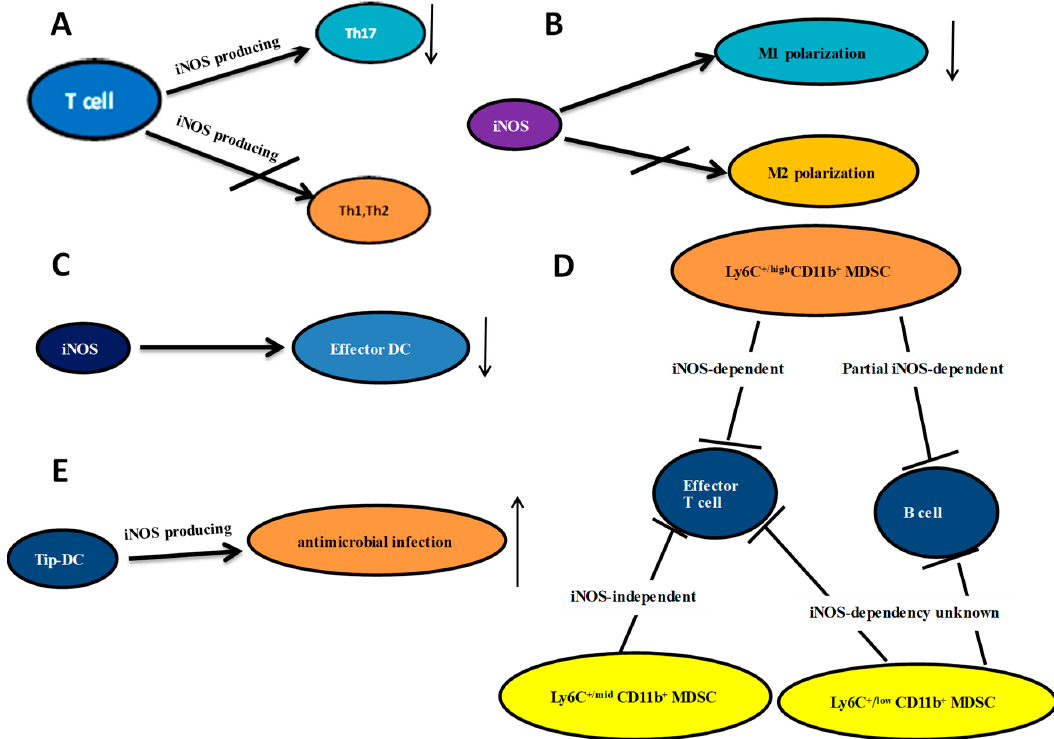
Figure 1. The relationship between iNOS and T cells, macrophages, dendritic cell, MDSC and Tip DC. ( A ) iNOS expressed by T cells negatively regulates Th17 differentiation without significant effects on Th1 or Th2 cells; ( B ) iNOS inhibits M1 polarization with no effect on M2 polarization; ( C ) The iNOS promotes effector DC differentiation; ( D ) MDSCs were sorted based on their cell surface expression of Ly6C and CD11b. The iNOS dependency of these relationships is listed; ( E ) Tip-DCs are important for antimicrobial infection; arrows ↓ : decreasing; ↑ :